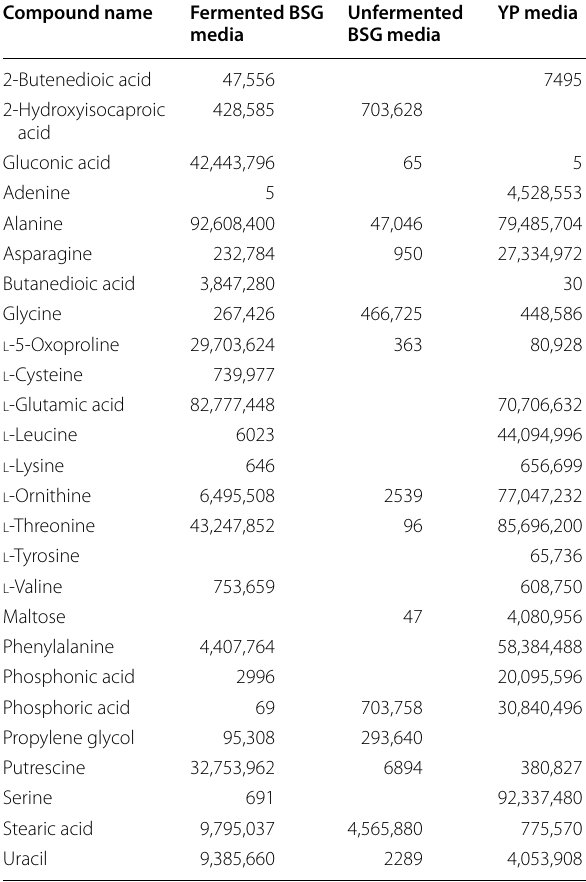
Table 2 List of identified metabolites extracted from the growth media with their relative